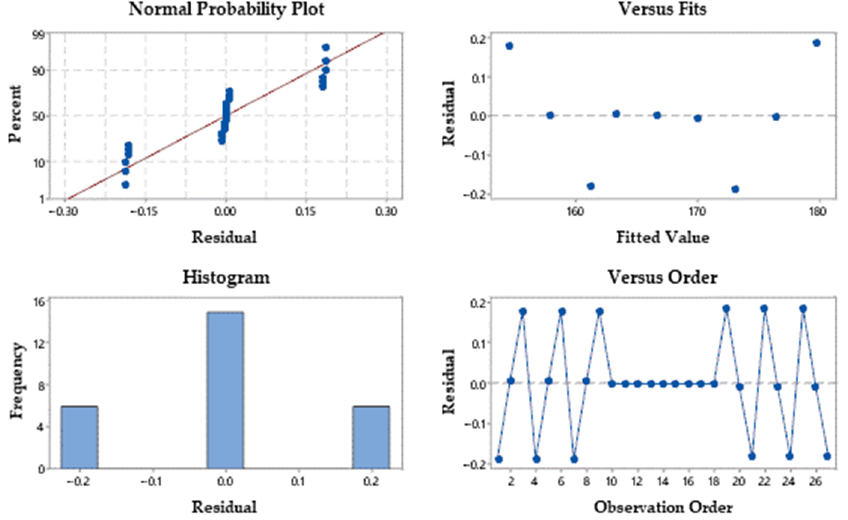
Figure 10. Residual plots for linear energy.